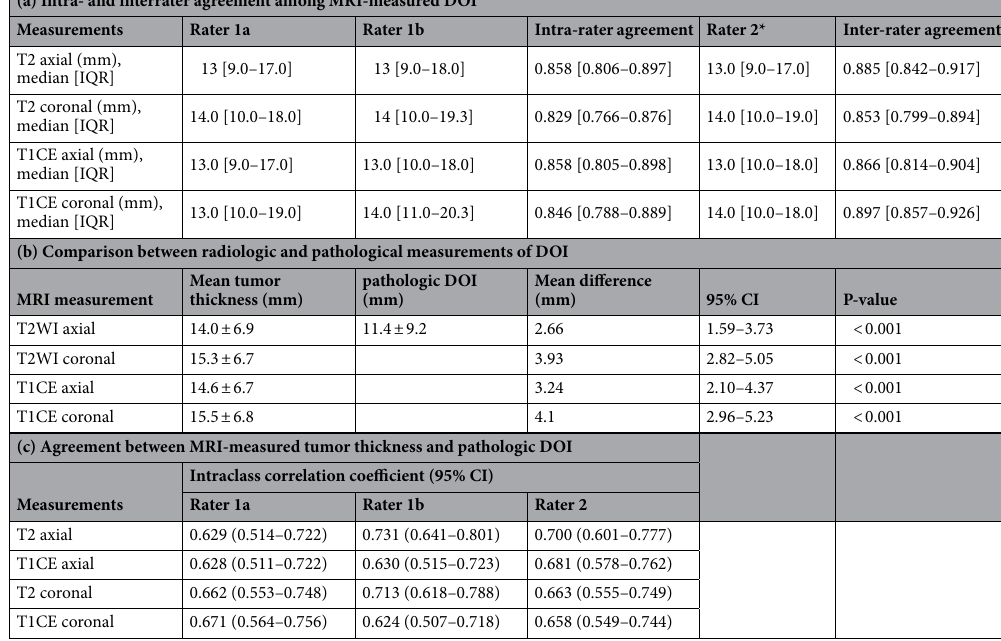
Table 2. Agreement and comparison of MRI-measured tumor thickness and pathologic DOI. All P-values were < 0.001. *Agreement with Rater 1a; all P-values were < 0.001.